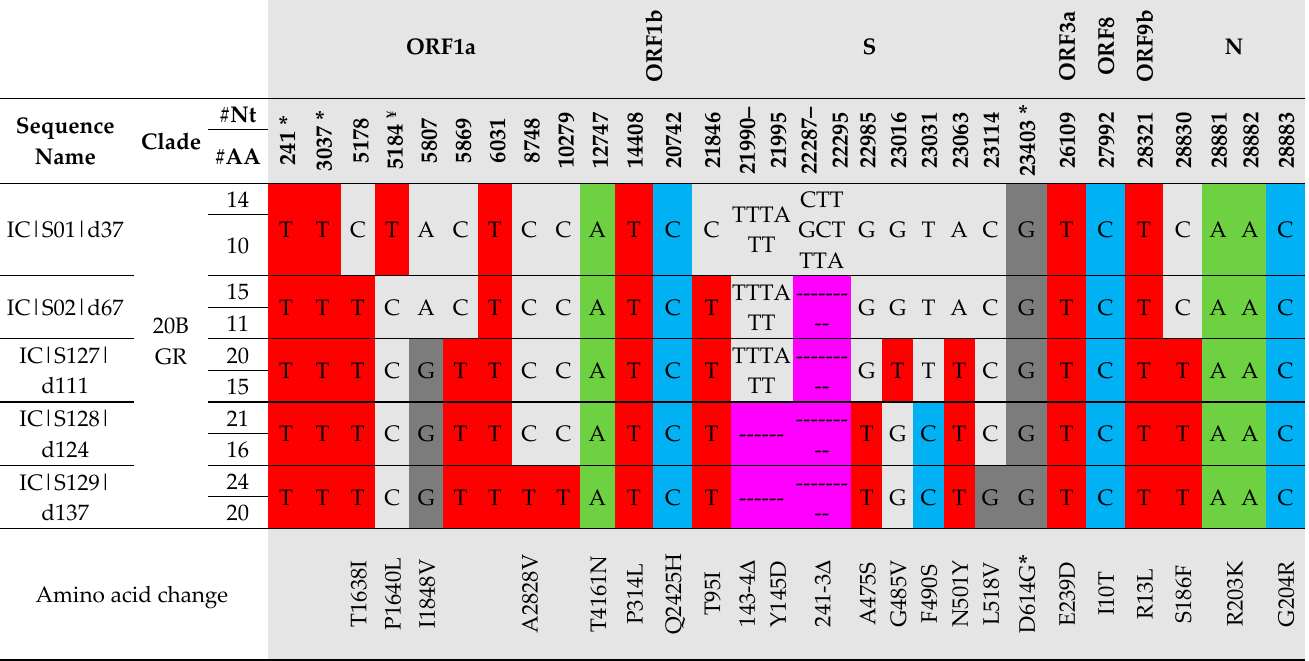
* Mutations defining GISAID’s G clade; ¥ Within the quasispecies of all samples, both C and T occur at this position. #Nt = number of nucleotide changes compared to Wuhan-Hu-1; #AA = number of amino acid changes compared to Wuhan- Hu-1. Clade = respectively Nextstrain (20B); GISAID (GR) nomenclature. IC = immunocompromised patient; d = day; ORF = open reading frame; M = membrane; S = spike; N =